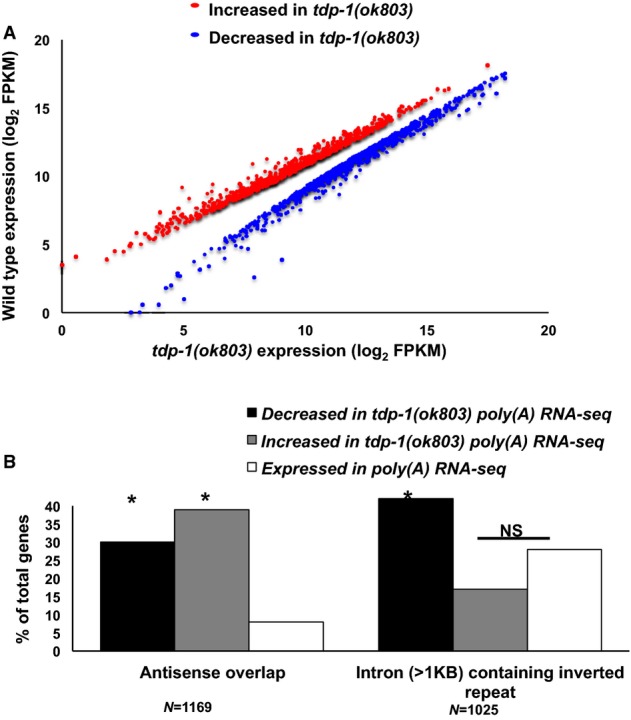
TDP-1 maintains transcripts with potential dsRNA structureScatter plot comparing the log2 of transcript RPKMs (Reads Per Kilobase of transcript per Million mapped reads) between wild-type and tdp-1(ok803) poly(A)-selected RNA-seq experiments. Only transcripts significantly (corrected P < 0.05) increased (red) or decreased (blue) compared to wild-type are shown. Scatter plot represents significantly different genes calculated from two independent biological replicates of both wild-type and tdp-1(ok803) poly(A) RNA-seq prepared from L4 animals.Percentage increased and decreased transcripts in tdp-1(ok803) poly(A) RNA-seq that have antisense overlap with another spliced gene or have intronic sequences (> 1 kb) that contain inverted repeats. *P < 1 × 10−4 (hypergeometric distribution); NS, not significant relative to control gene sets.